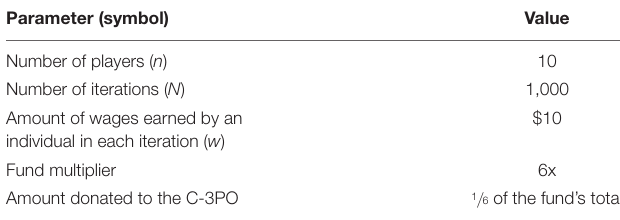
TABLE 1 | Simulation